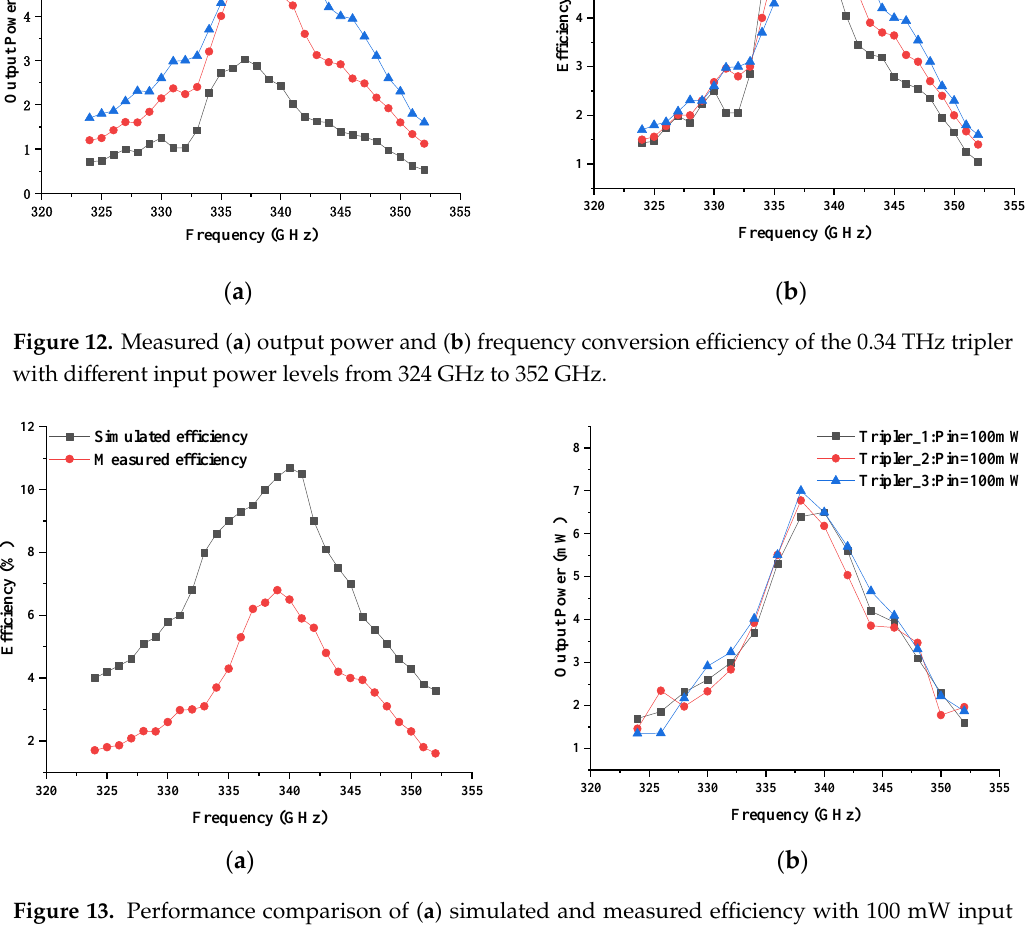
Figure 13. Performance comparison of ( a ) simulated and measured efficiency with 100 mW input power and ( b ) measured output power of three different tripler modules with 100 mW input power.